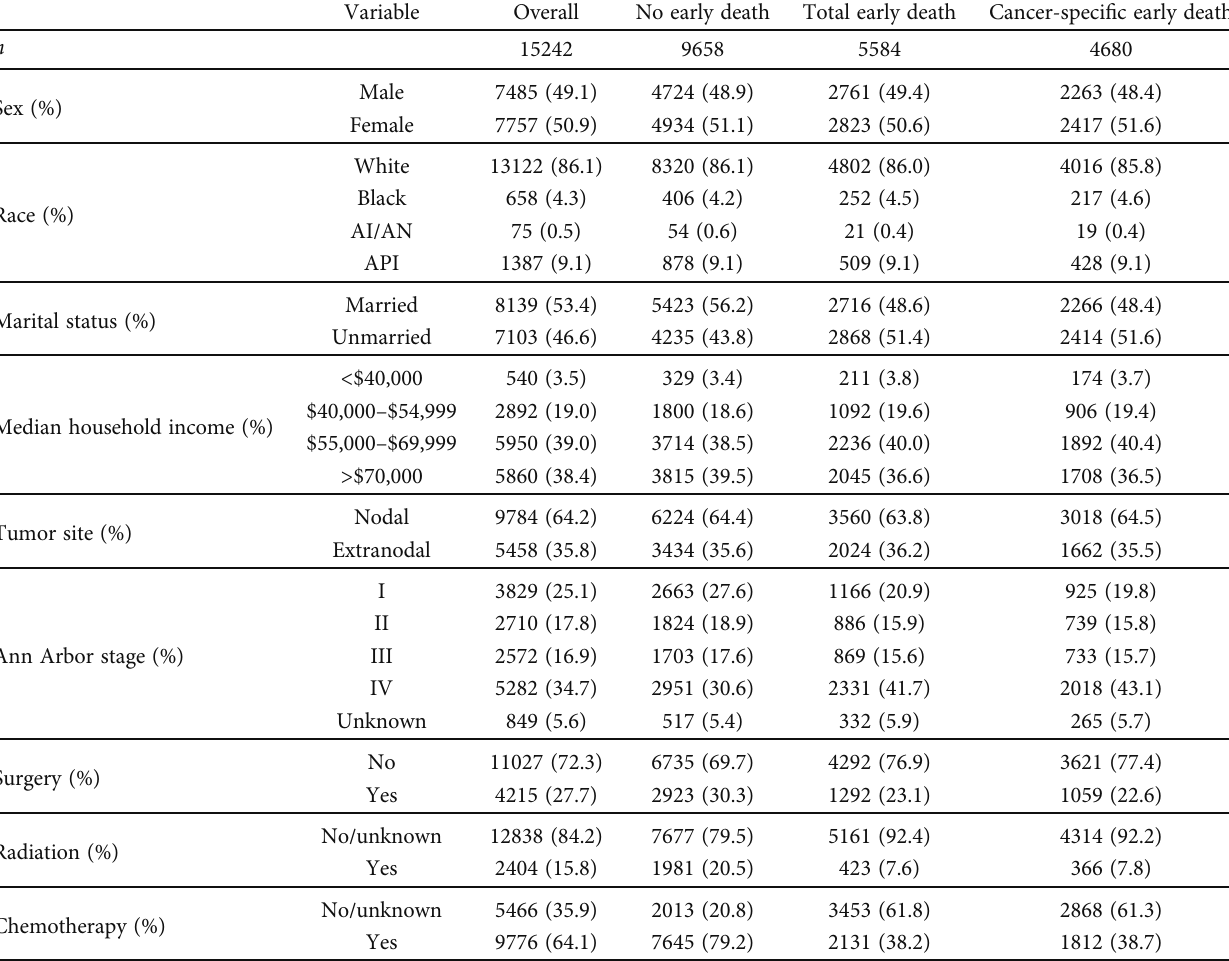
Table 2: Rate of early death in older patients with